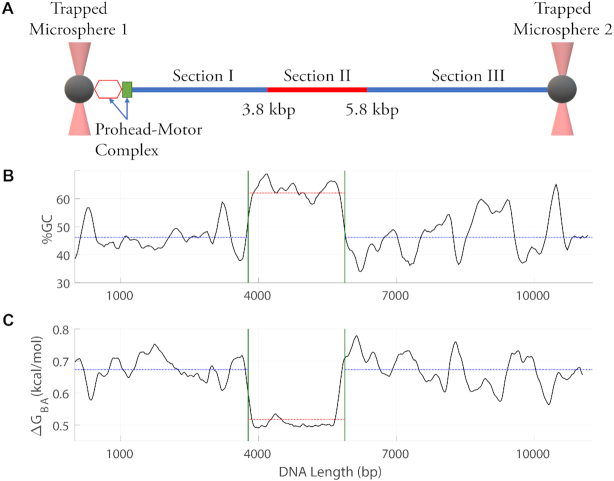
Schematic illustration of the DNA construct design and packaging measurement. (A) T4 prohead–motor complexes are attached to one microsphere trapped with optical tweezers (left) and DNA is attached to a second trapped microsphere (right). A linear plasmid DNA sequence was designed with a synthetic A-philic, high GC content sequence (section II) between two ‘normal’ non-A-philic flanking plasmid DNA sequences (sections I and III). DNA translocation by the motor begins at left and proceeds from section I to II to III. (B) Average % GC versus position along the DNA calculated in a 200 bp sliding window. (C) Predicted free energy difference per basepair (ΔGBA) between B-form and A-form DNA structures versus position calculated in a 200 bp sliding window. In panels (B) and (C), the vertical lines indicate the beginning and end of section II, the horizontal lines indicate average %GC and ΔGBA for sections I and III, and the dashed red line indicates average %GC and ΔGBA in section II.